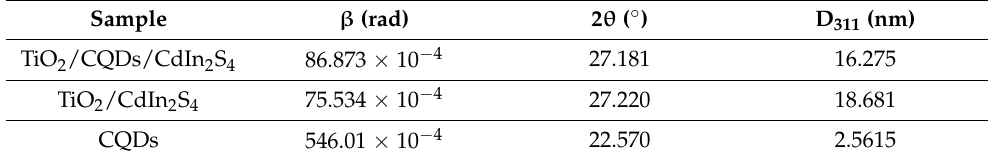
Table 1. The crystal sizes of the photocatalysts and CQDs calculated by Debye–Scherrer equation. Sample β (rad) 2 θ ( ◦